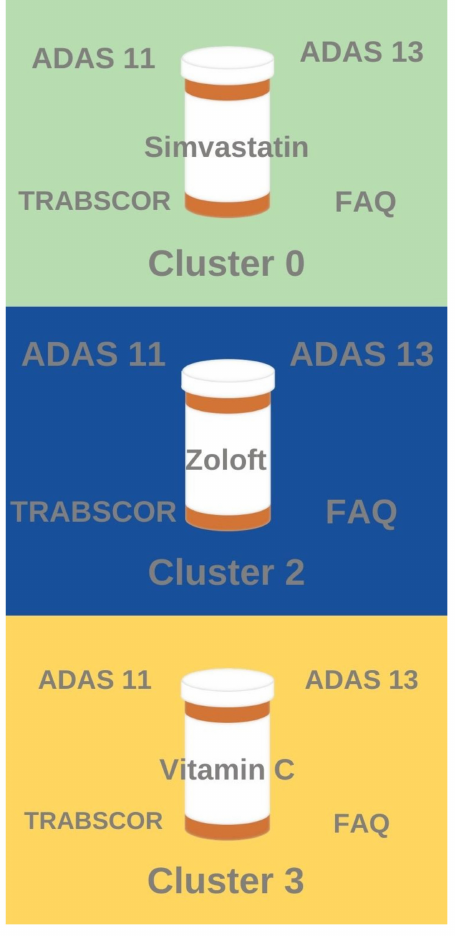
Figure 5. Visualization of the association rules found between AD sub-populations (clusters) and prescribed drugs or supplements. The relative font size of the cognitive test scores indicate